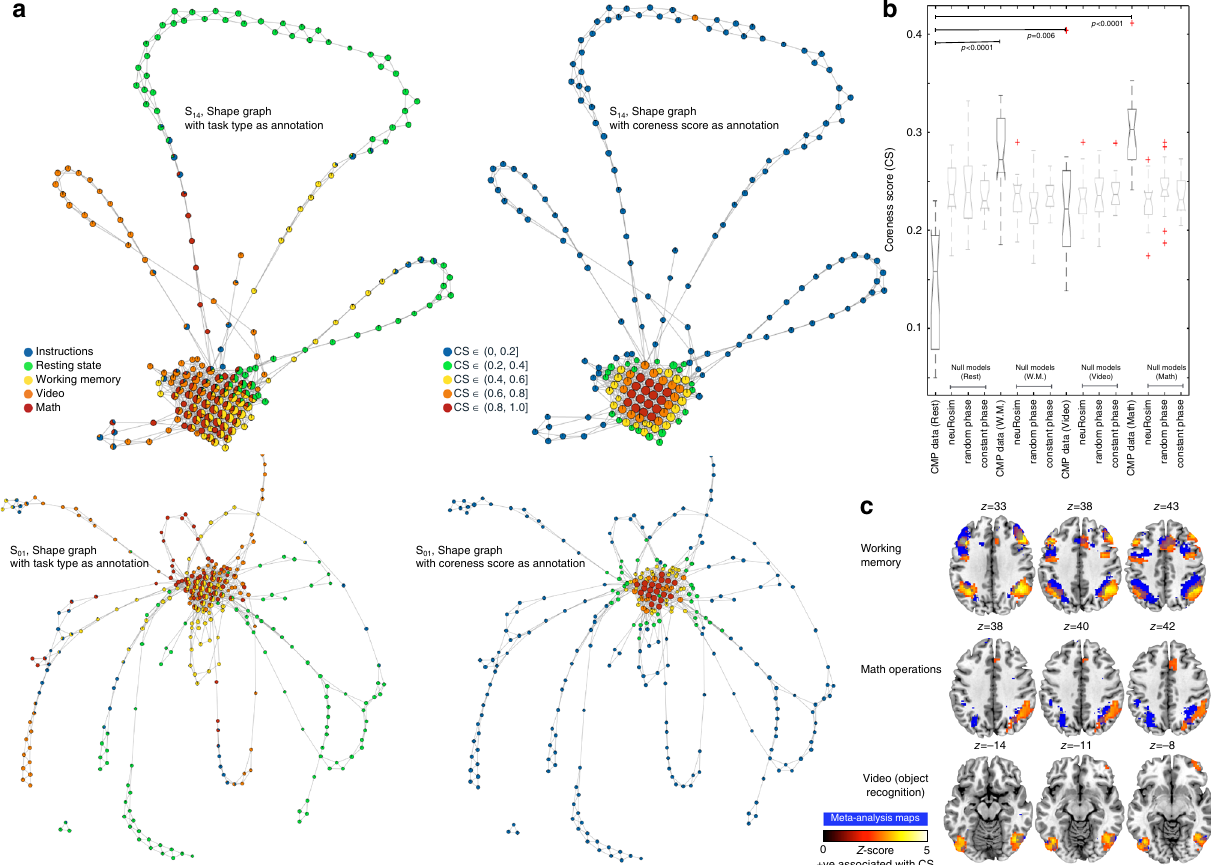
Fig. 4 Quantifying the mesoscale core − periphery structure of shape graphs. a Shows shape graphs for two representative participants (S 14 and S 01 ). In the left column, we annotated the nodes using task-type and in the right column the nodes are annotated using the coreness scores (CS). As evident, the more central and densely connected nodes have high CS and more sparsely and peripheral nodes have less CS. b Shows boxplots of CS derived from the CMP data as well as from the three null models (neuRosim, phase randomization with random, and constant phase). Across the four CMP tasks, nodes containing resting time frames had the lowest CS, while the nodes containing time frames from cognitively demanding tasks mainly lied relatively deeper inside the shape graph (i.e. higher CS). The CS of nodes with resting time frames was also lower than all the three corresponding null models ( p s < 0.001), and the CS of nodes with working memory or math frames was higher than all the three corresponding null models ( p s < 0.005). No signi fi cant difference was observed for the CS of nodes with time frames from the video task and the corresponding null models. c Shows the brain regions that were positively associated with coreness scores, i.e., higher the CS, higher the activation in these regions. The group-maps (in red-yellow scale) for positive relation with CS are overlaid on the task-associated meta-analysis maps from NeuroSynth 44 . As shown, higher CS was associated with higher engagement of